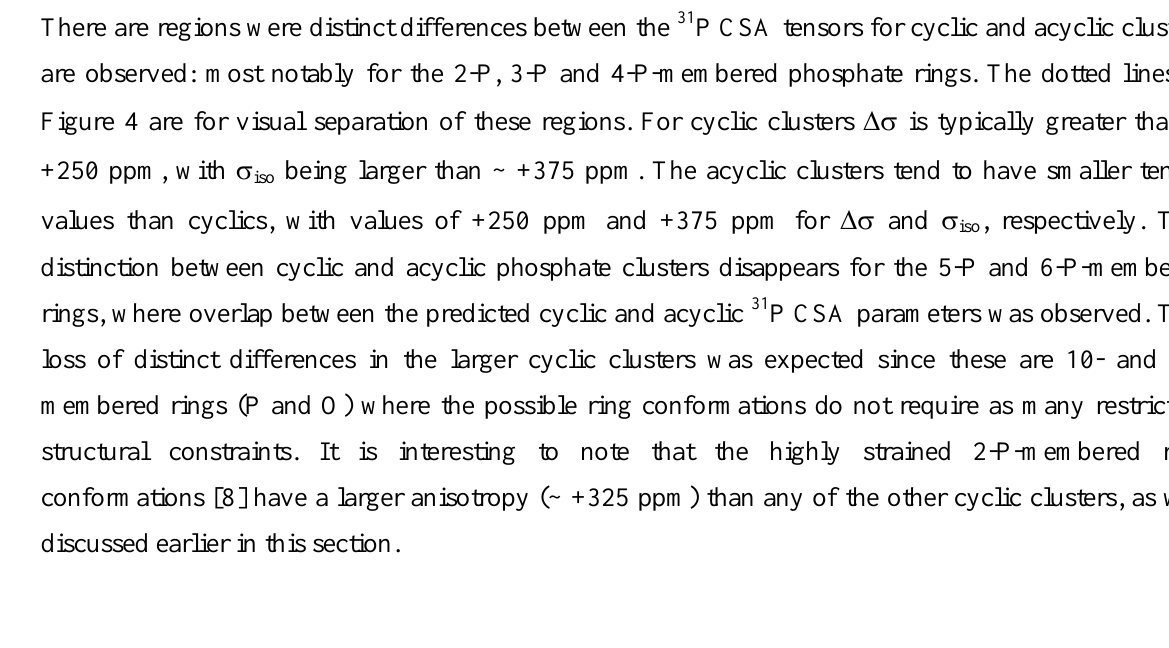
) versus shielding iso